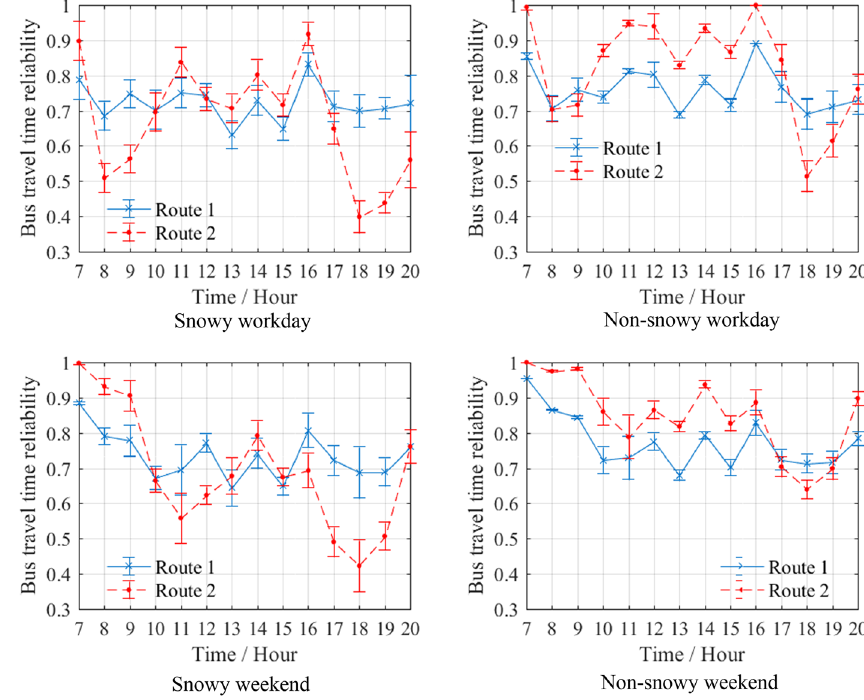
Fig. 17 Bus travel time reliabil- ity in different